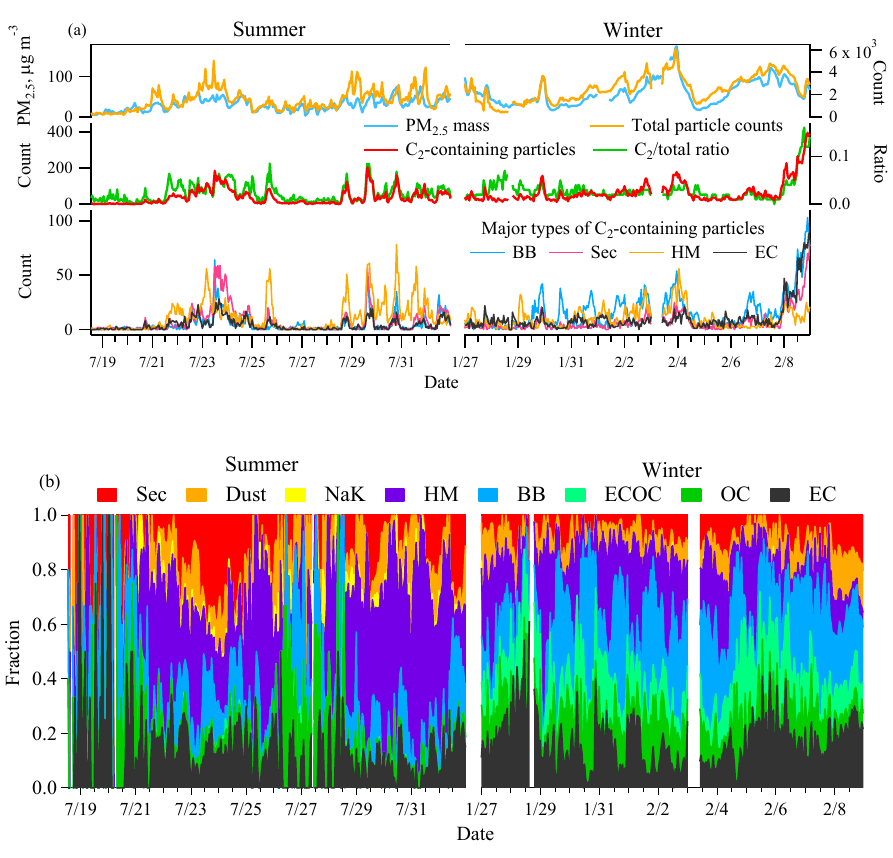
Figure 1. Temporal variations in total detected particles and oxalic-acid-containing particles during the whole sampling period in Heshan, China: (a) hourly variations in PM 2 . 5 mass concentration, total detected particle counts, oxalic acid containing particles, ratio of oxalic-acid- containing / total particles and major types of oxalic-acid-containing particles; (b) variation patterns of relative abundance of major types of oxalic-acid-containing particles.